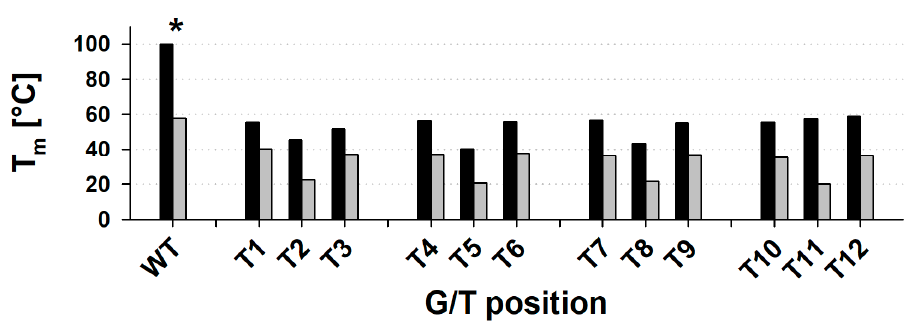
Figure 5. The T m of parallel (black) and antiparallel (gray) quadruplexes for WT sequences and all G/T substituted variants in 100K buffer. * - The T m of parallel WT sequence could not be determined because of the extreme stability of the parallel WT quadruplex in 100K